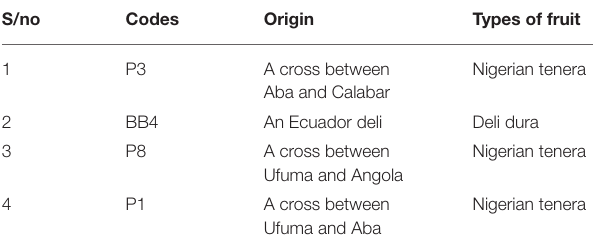
TABLE 3 | Parentage and origin of oil palm